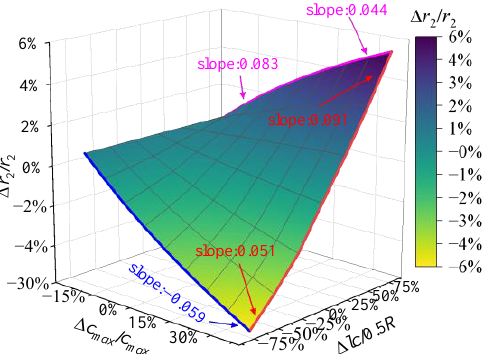
Figure 12. Sensitivity analysis for r 2 . Base state: c max / c R = 1.4, location of the maximum chord length lc = 0.5 R , r 2 = 0.574.